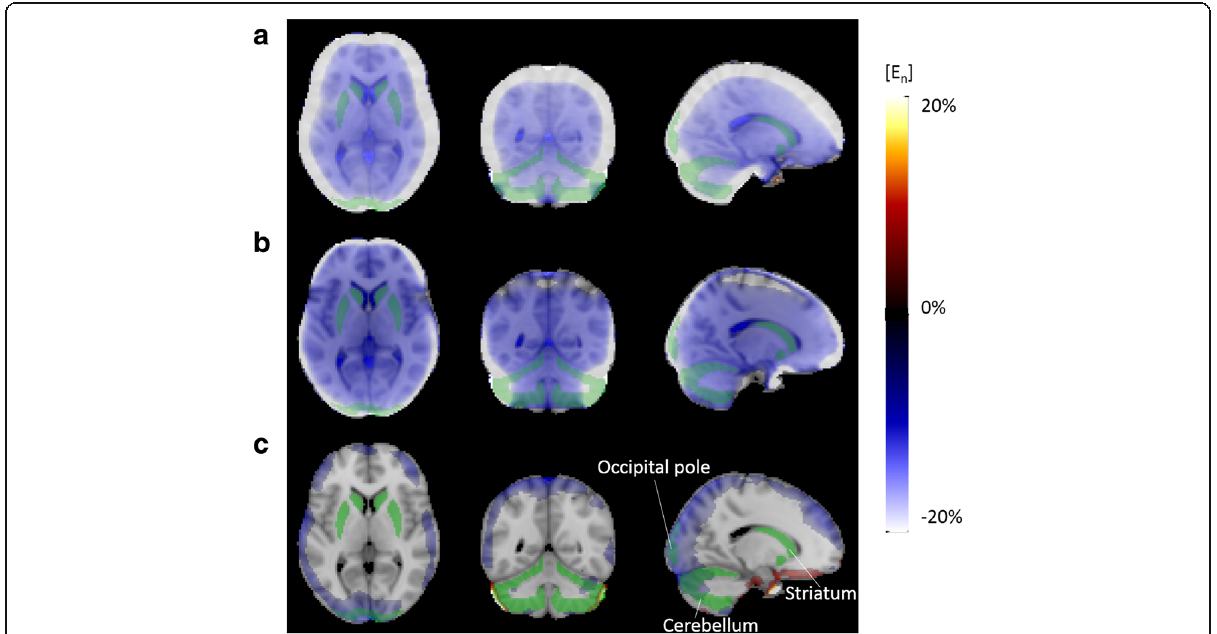
Fig. 4 Axial (left), coronal (middle), and sagittal (right) views of the normalised voxel-wise En maps obtained with the μ -map DXN ( a ), μ -map dUTE